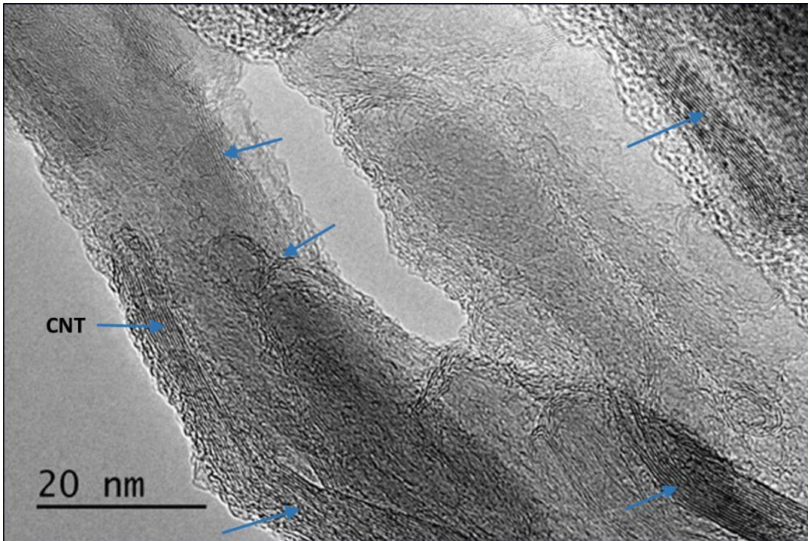
Figure 2. HRTEM micrograph of the CNT–polymer structure showing the nanotube location (marked by arrows) in the composite cluster. Bare polymer was identified in the center of the